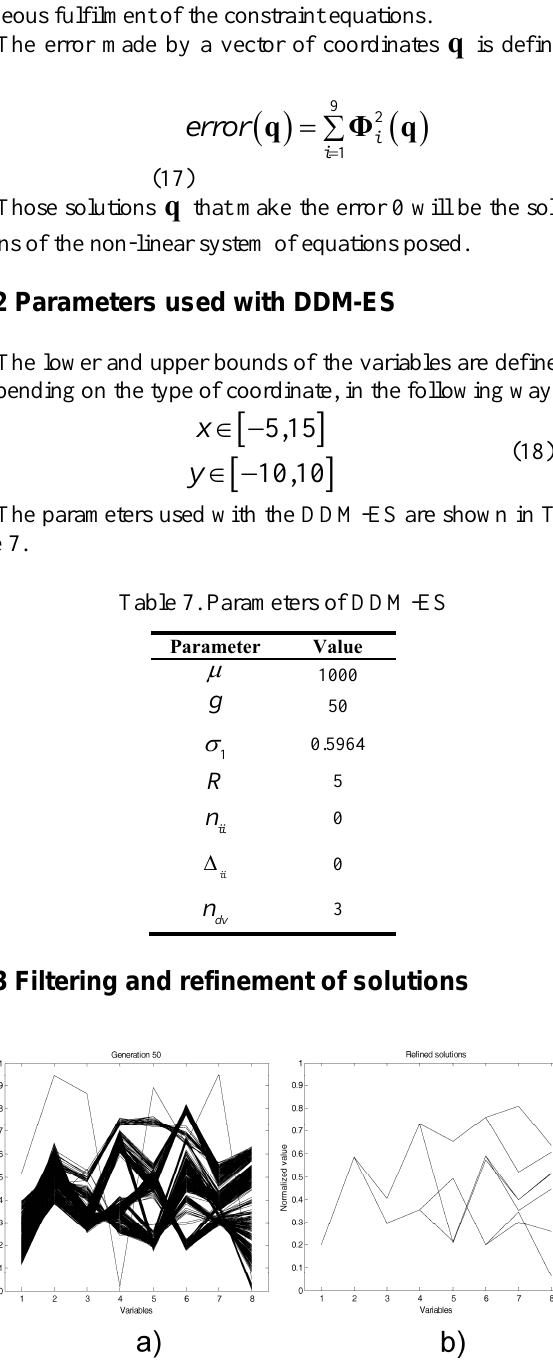
Fig. 9 Population in generation 50 and filtered and refined